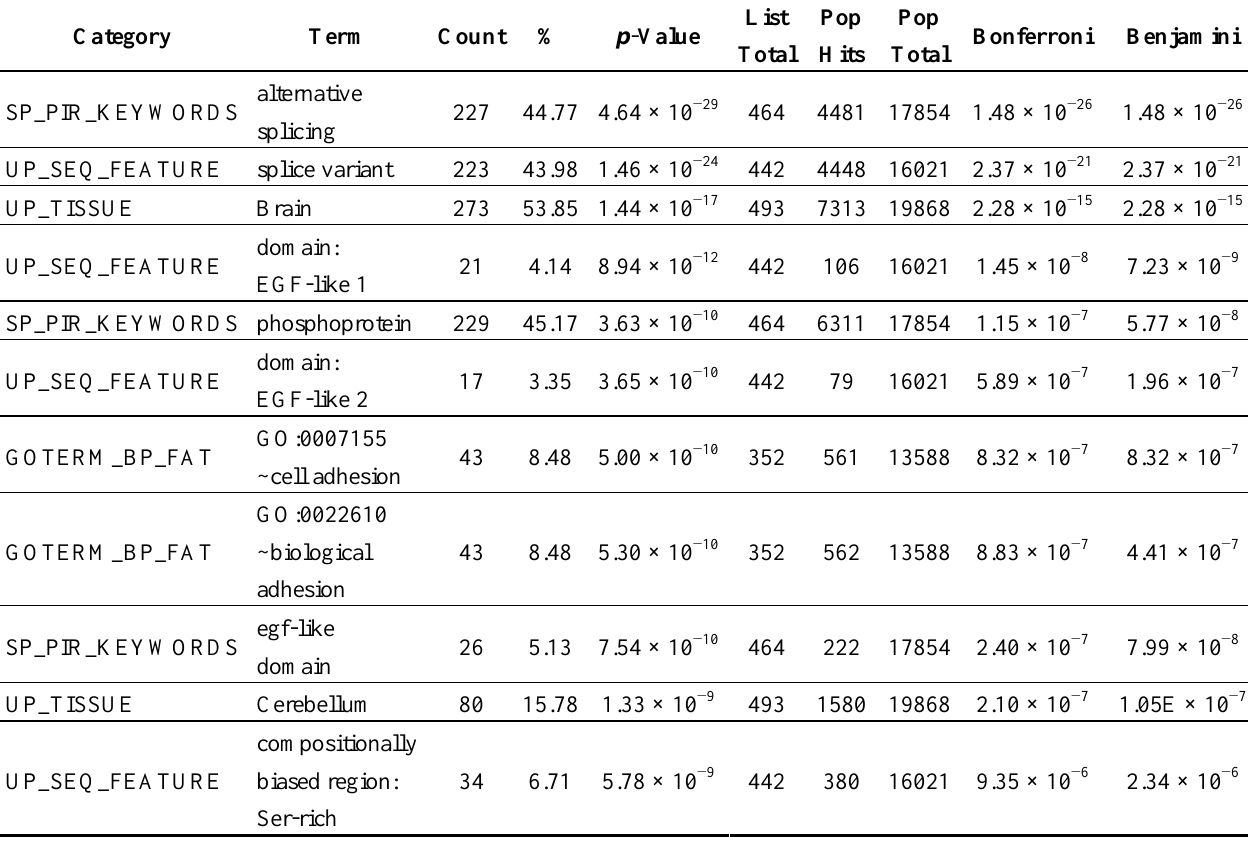
Table 1. The most recurrent functional annotation genes hosting pol III transcriptional units. The table represent a schematic view of the output obtained by DAVID analysis. “Category” indicates the original database or resource where the terms orient; “Term” column lists the enriched terms associated with the gene list; “Count” and “%” are the number/percentage of the genes enriched in a term; “ p -Value” indicates the statistical significance of the enrichment; “List total” is the number of the genes recognized by the Category; “Pop Hits” is the number of genes enriched by a term in a Category; “Pop Total” is the total number of genes in a Category; “Bonferroni” and “Benjamini” are two different coefficients that indicate the statistical significance of the enrichement respect to the